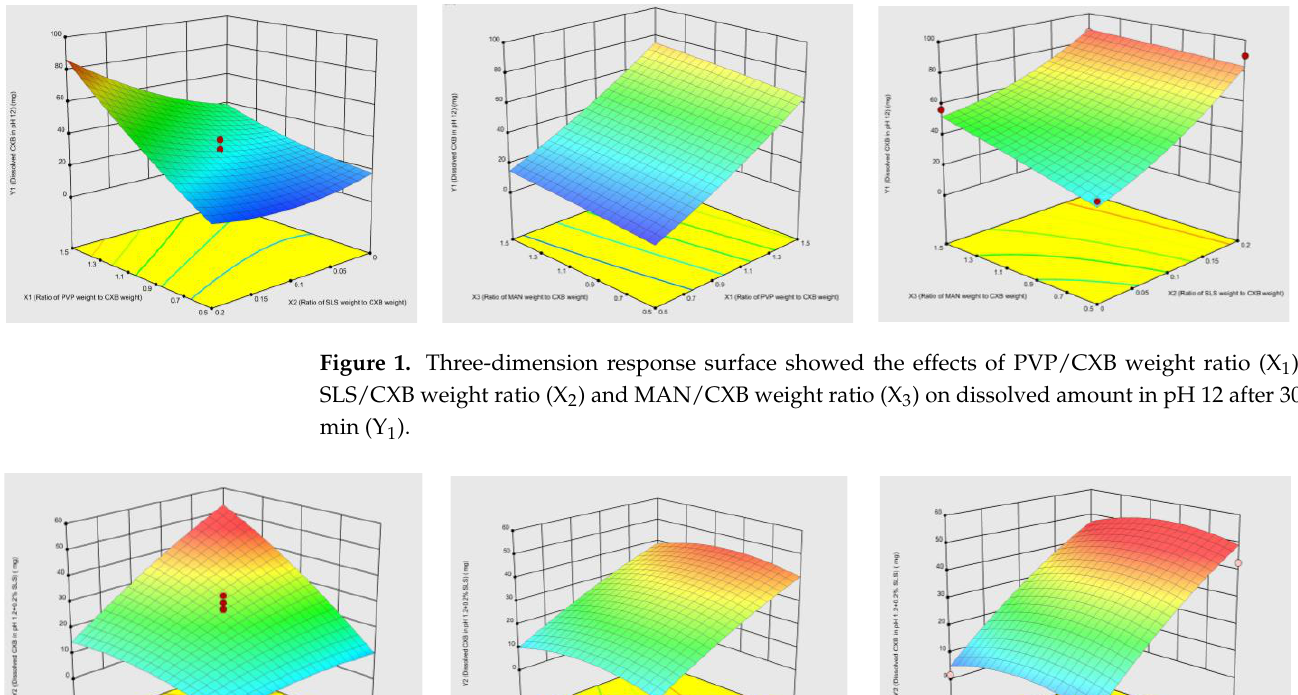
Table 6. The experimental and the predicted results of the optimum co-milled CXB composition based on desirability function.